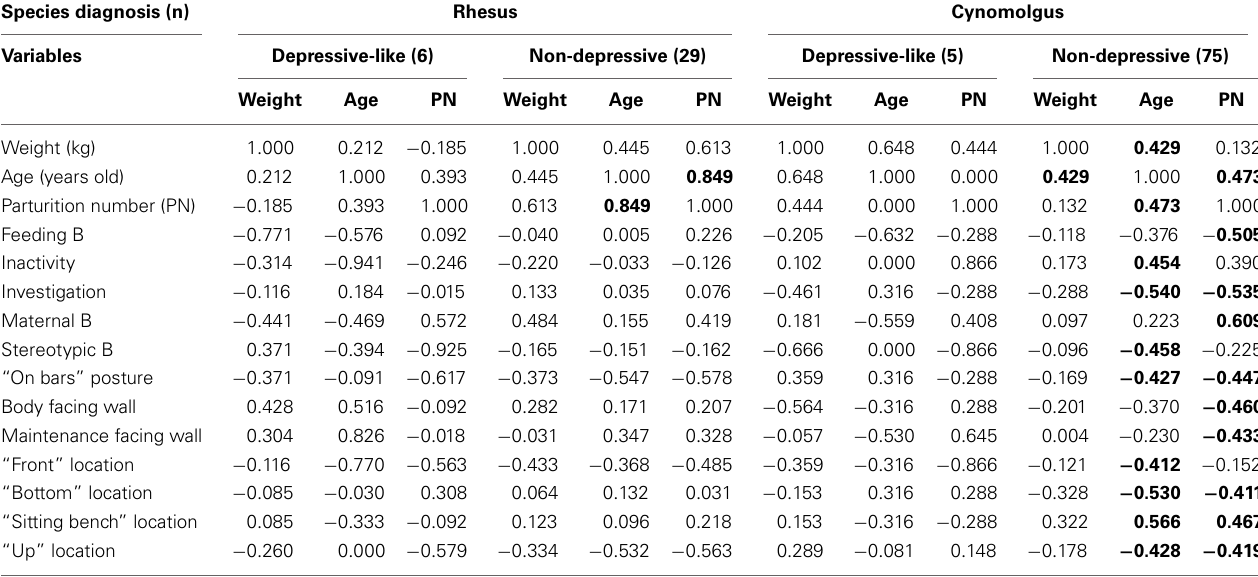
Table 5 | Significant Spearman rank correlations between weight, age, parturition number, and other collected parameters in socially-housed depressive-like and non-depressive